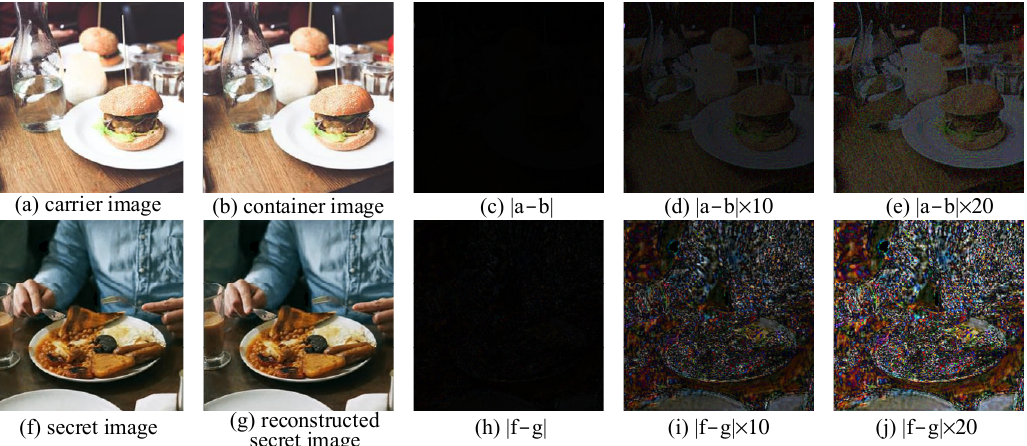
Figure 9. Difference images between carrier and container images, and secret and reconstructed secret images.